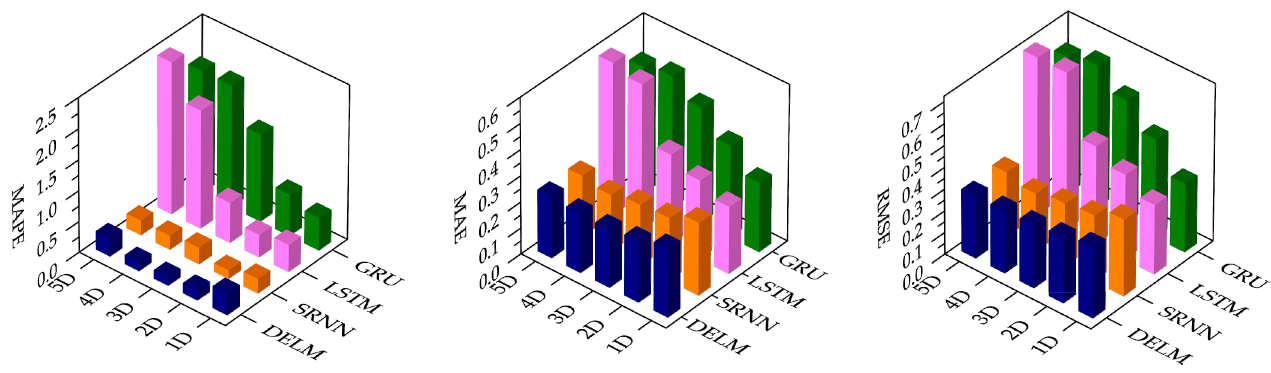
Figure 7. Error indices of different models.